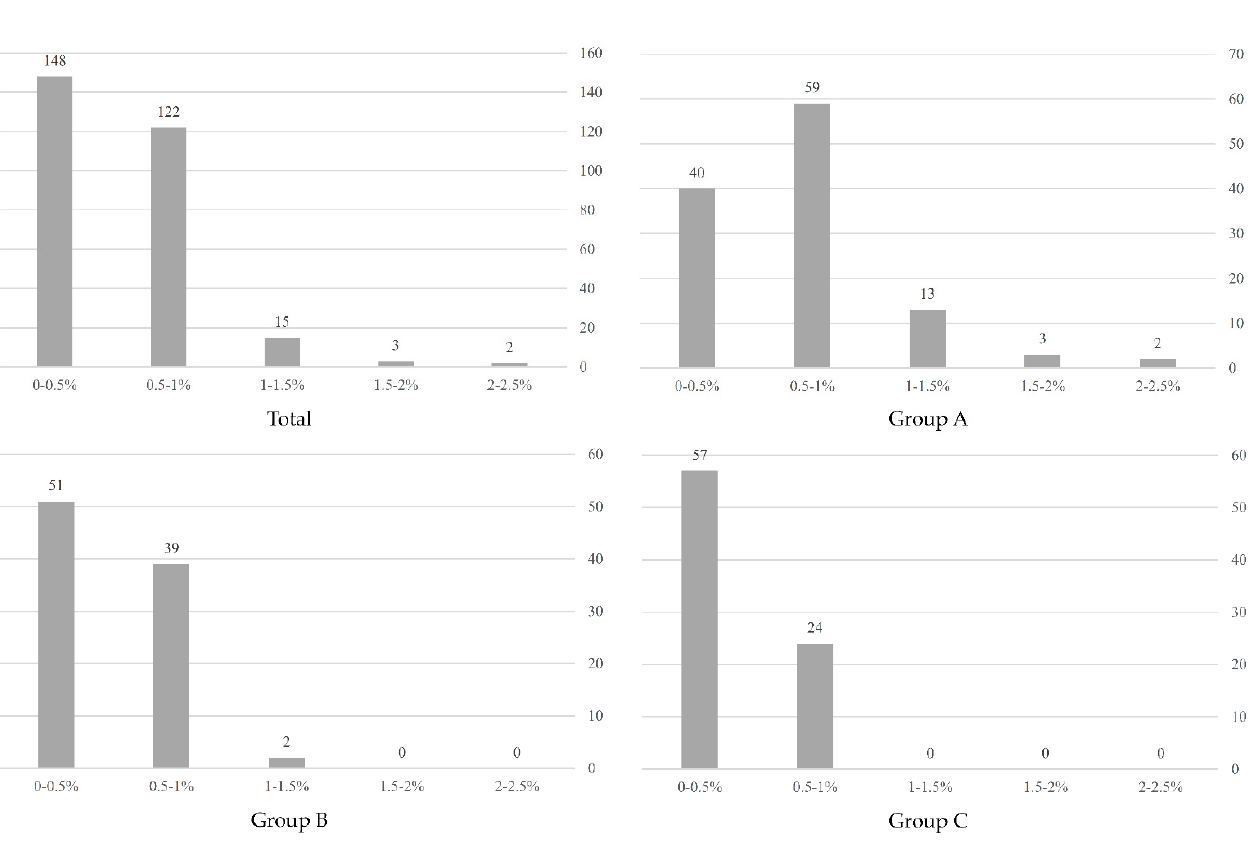
Figure 5. Histograms of groups to construction cost scale.